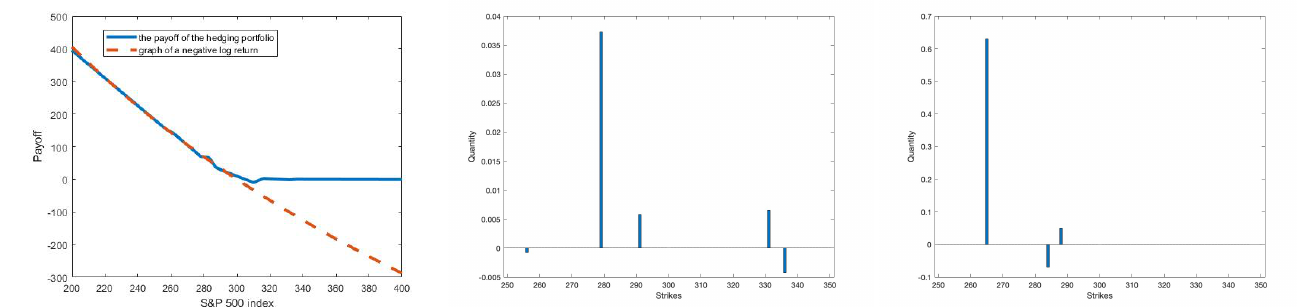
Figure 10. The payoff of the hedging portfolio together with the payoff of the claim being priced of a log-option ( left ), the hedging portfolios for the put option ( center ) and call option ( right